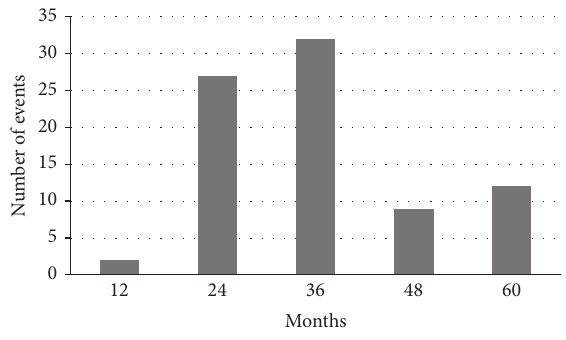
Figure 1: Distribution of events during